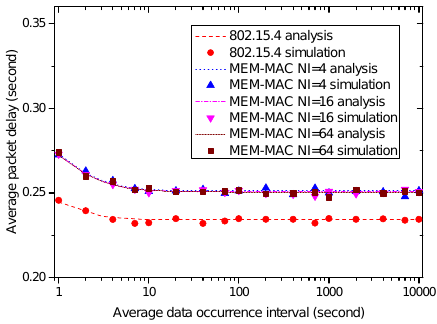
Figure 14. How the average frame delay changes with the average data occurrence